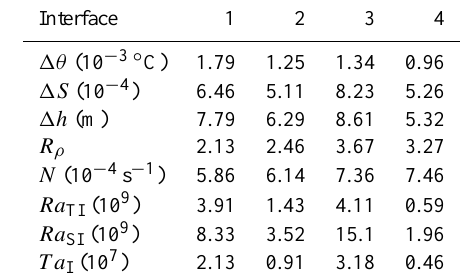
Fig. 1. (a) A sketch of temperature distribution of a diffusive inter- face in DC staircases; δ is the boundary layer thickness of a con- vecting layer. (b) A cartoon of flow pattern near the interface.